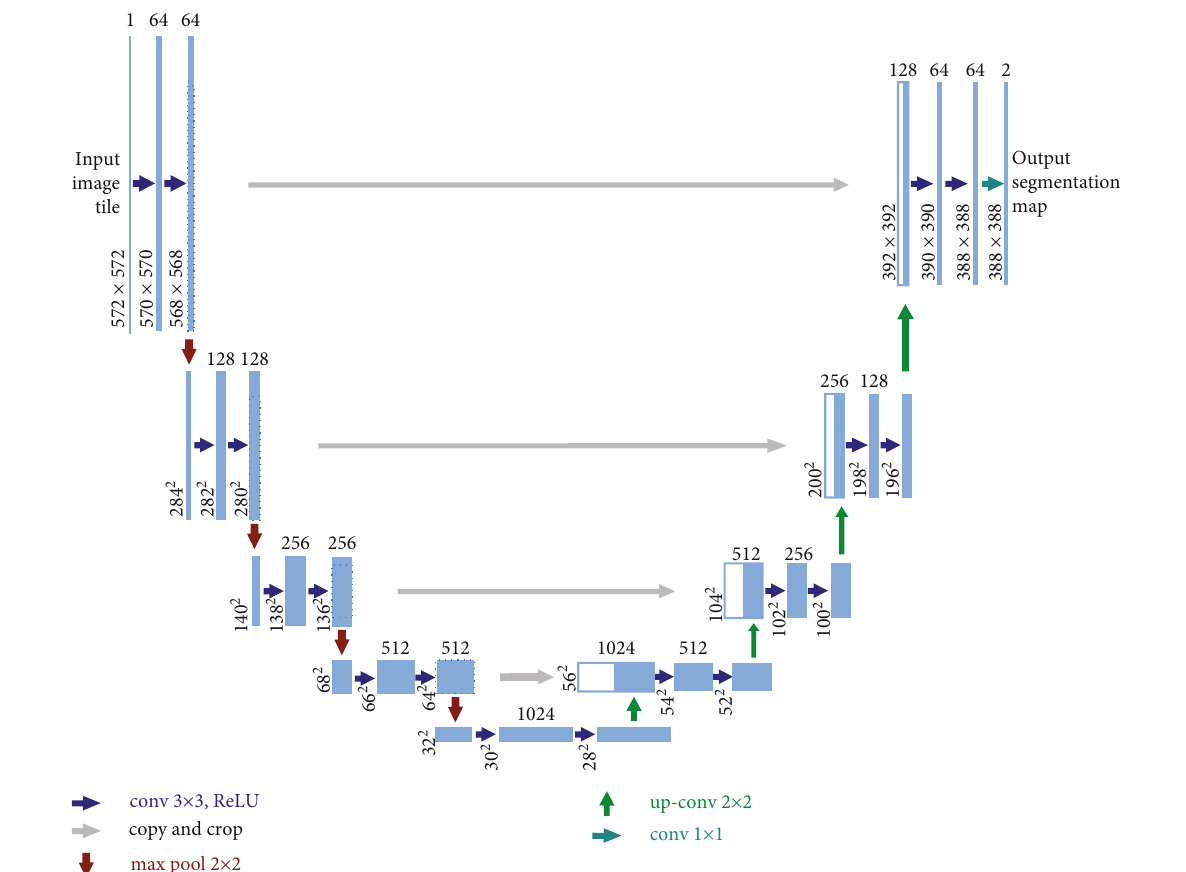
Figure 7: Structure of the U-net